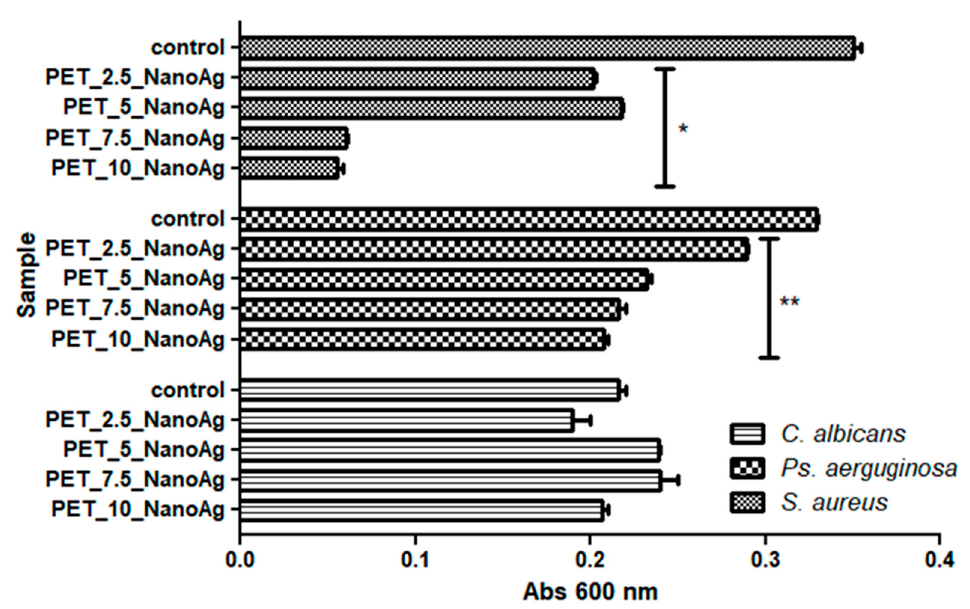
Figure 7. Graphic representation of the recorded absorbance values of Staphylococcus aureus , Pseudomonas aeruginosa , and Candida albicans cultures, expressing the multiplication capacity of these cells after cultivation for 24 h in the presence of recycled PET_X_NanoAg materials. * p ≤ 0.001, ** p ≤ 0.05 after the comparison of control with NanoAg-containing PET fibers obtained by applying various flow rates).